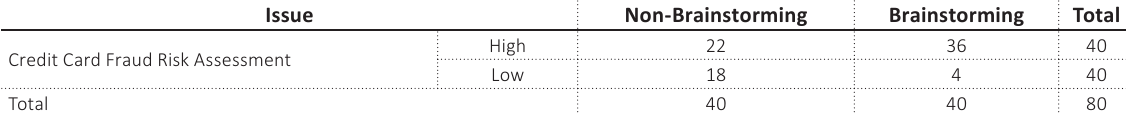
Table 3. Composition of the factorial design